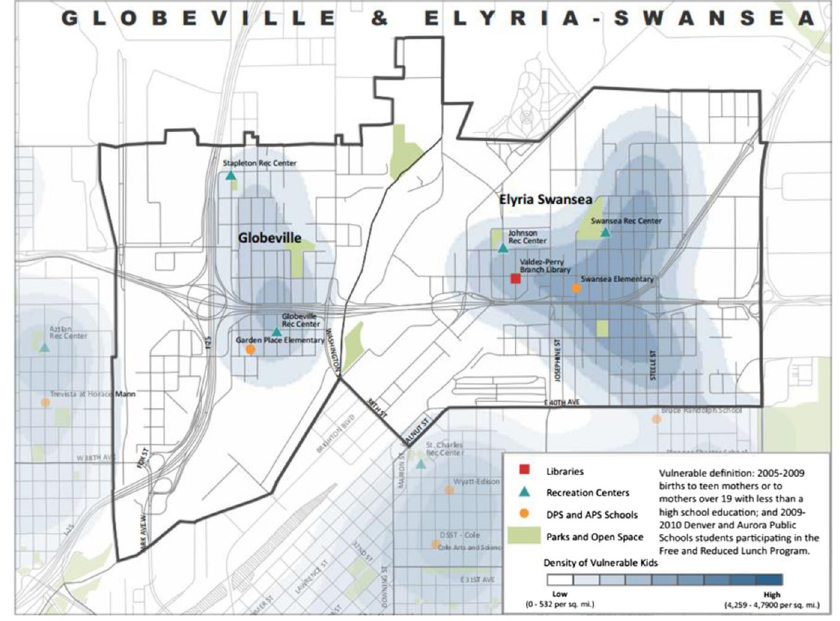
Fig. 4 Schools in Globeville, Source: Floodlight Project, 2019